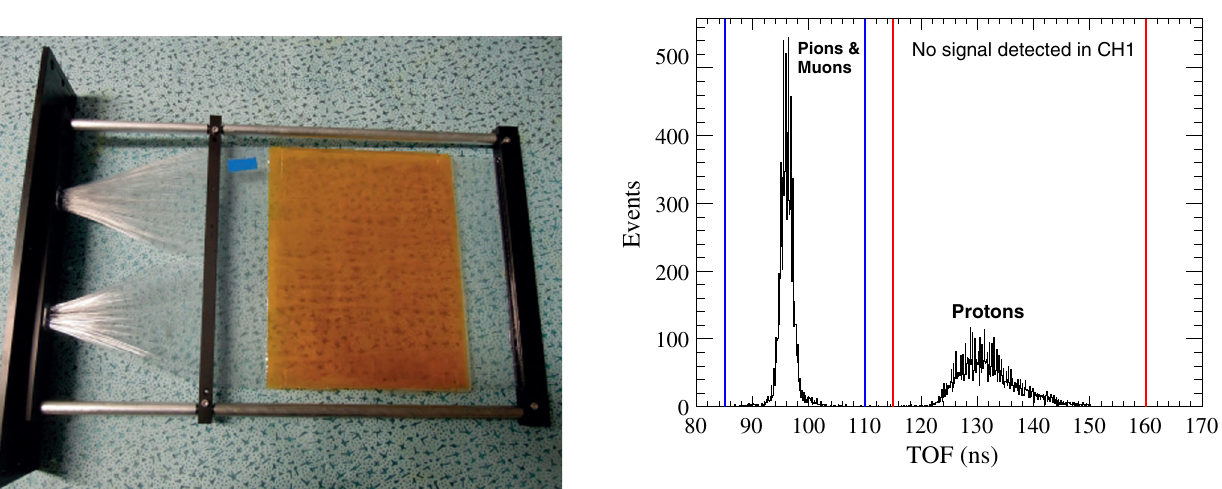
FIG. 12. XBTF module. The fibers are grouped in two clusters which are read-out through conventional PMTs. The coincidence signal of the three XBTFs is forming the beam trigger, which is sent to the experiment as well as to the XBPF monitors.